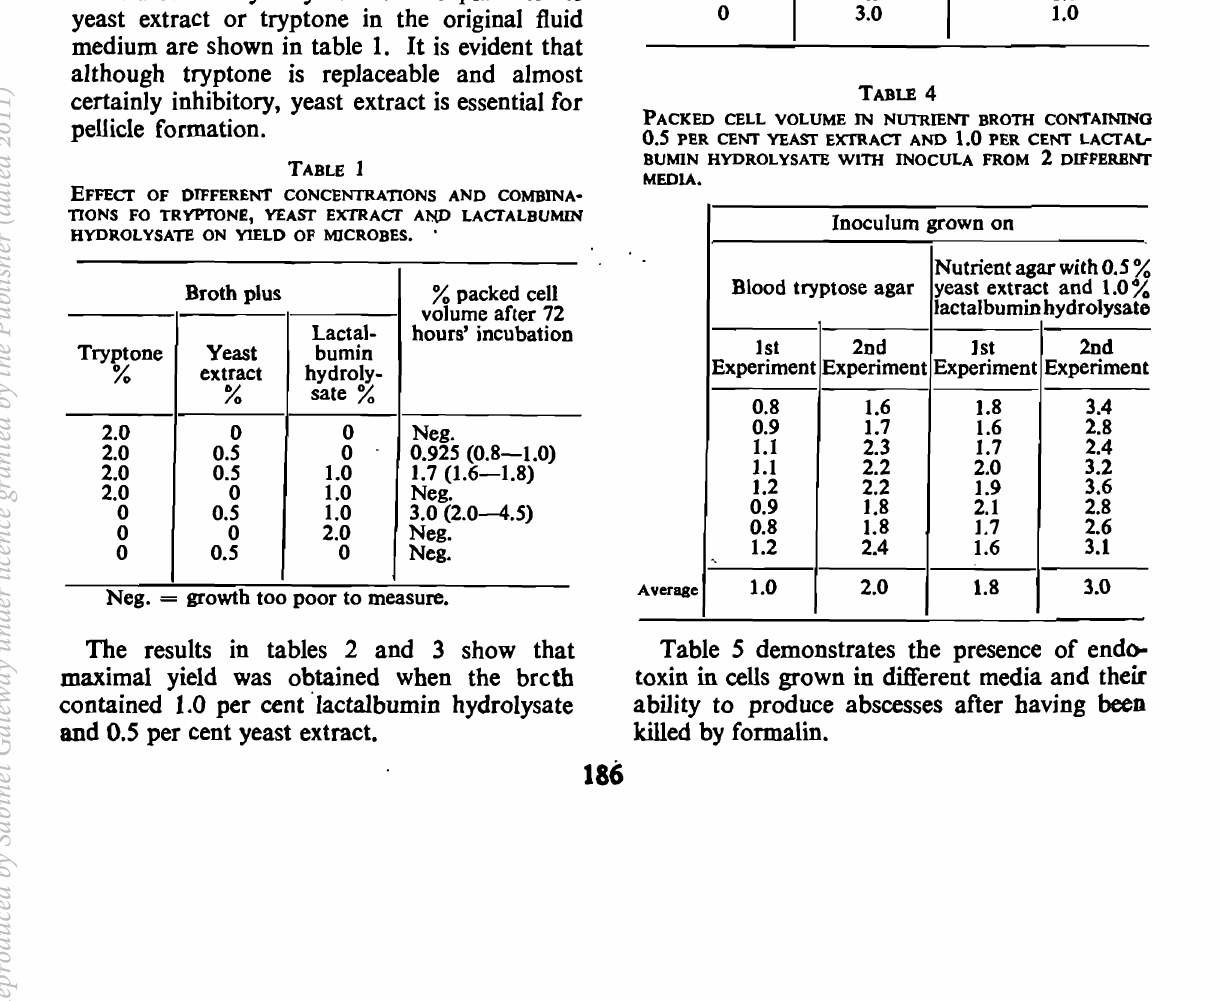
EFFECI' OF DIFFER£NT CONCENTRATIONS AND COMBINA TIONS FO TRYP'roNE, YEASI" EXTRACT Al!!O